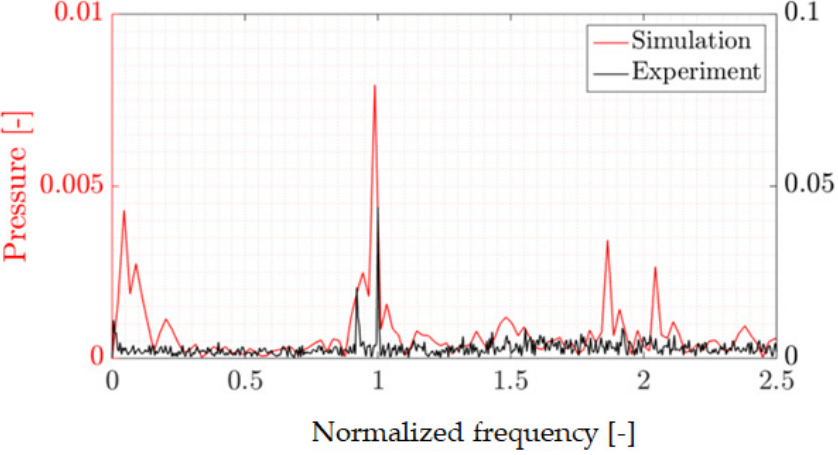
Figure 13. Amplitude spectrum of the pressure at P-PS-3 (pressure side, near the trailing edge). Two vertical axes are used; numerical results—red, experimental results—black.